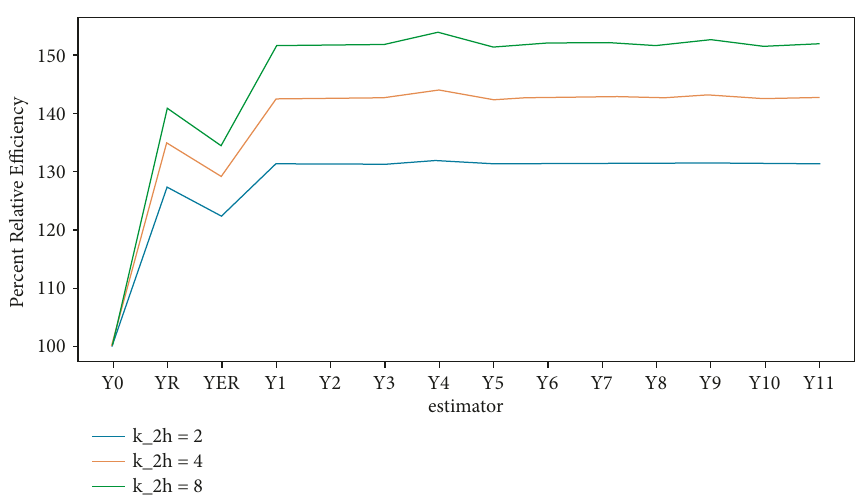
Figure 5: Plot of PREs at 20% nonresponse and 0.2 sensitivity level for population